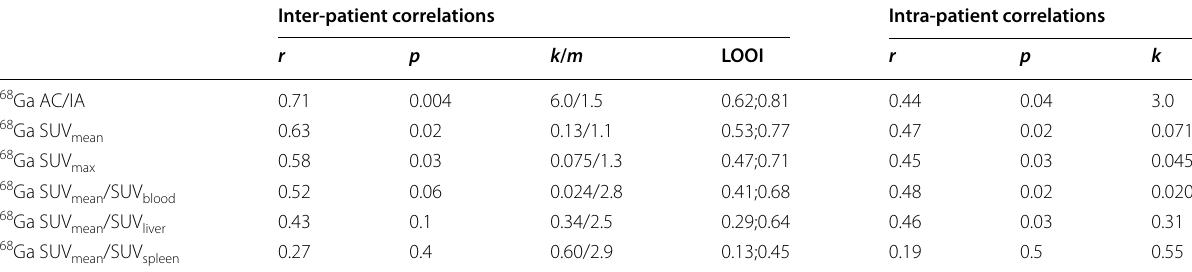
Correlation coefficients ( r ), p-value ( p ), coefficients for the linear equation ( y